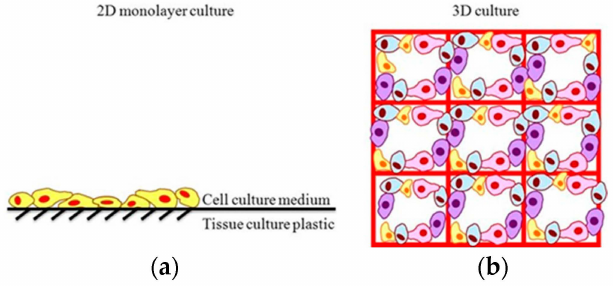
Figure 1. Structural comparison of ( a ) Two-dimensional cell culture and ( b ) Three-dimensional cell